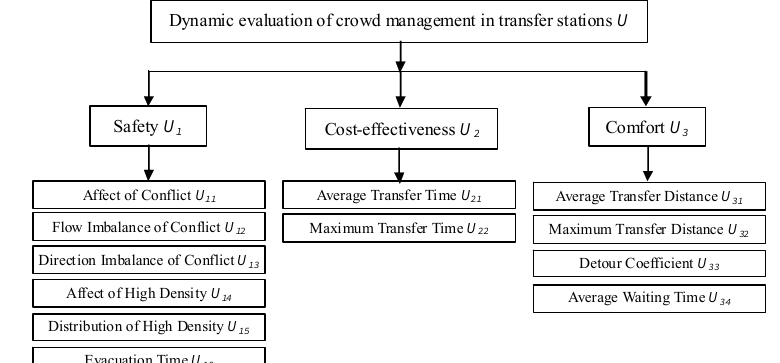
Fig. 2. Dynamic evaluation indicators system of crowd management for transfer